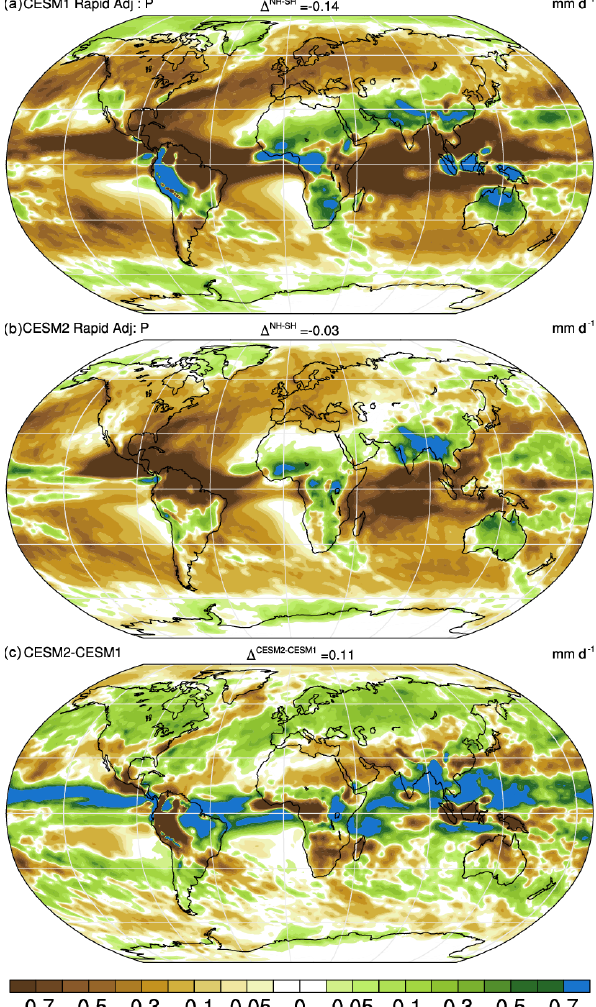
Figure 6. The rapid adjustment of total precipitation to CO 2 qua- drupling for CESM1 (a) , CESM2 (b) , and their difference (c) based on estimates from 4 × CO 2 AMIP and AMIP simulations. Differ- ences in the hemispheric means are shown in panel titles. All units are mmd − 1